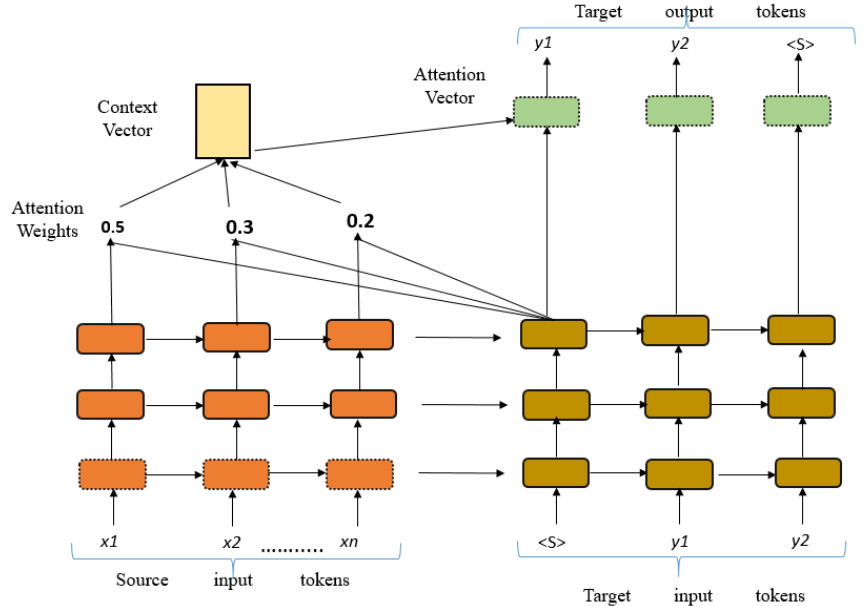
Figure 6. The attention mechanism provides additional alignment information rather than just using fixed sized context